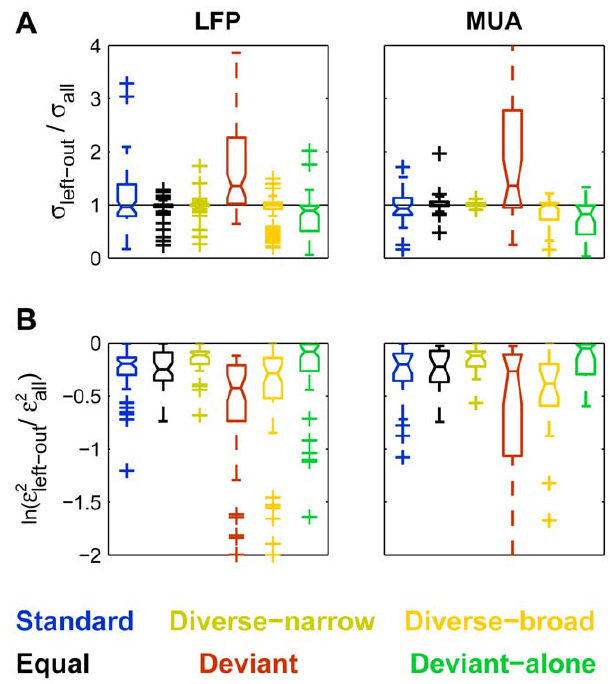
Figure 12. Comparing model error and half-bandwidth be- tween all-data and leave-one-out models. A. Distribution of the ratios of the widths of the adaptation channel derived from a model for which responses to one condition were left out of the training data, and the width derived from a model that was fitted to all the data. The colors indicate the left-out condition. B. Distribution of ratios between the sum of squared errors of the model with the corresponding condition left out and the sum of squared errors of the model that was fitted to all the data (sums of squared error computed for the training data